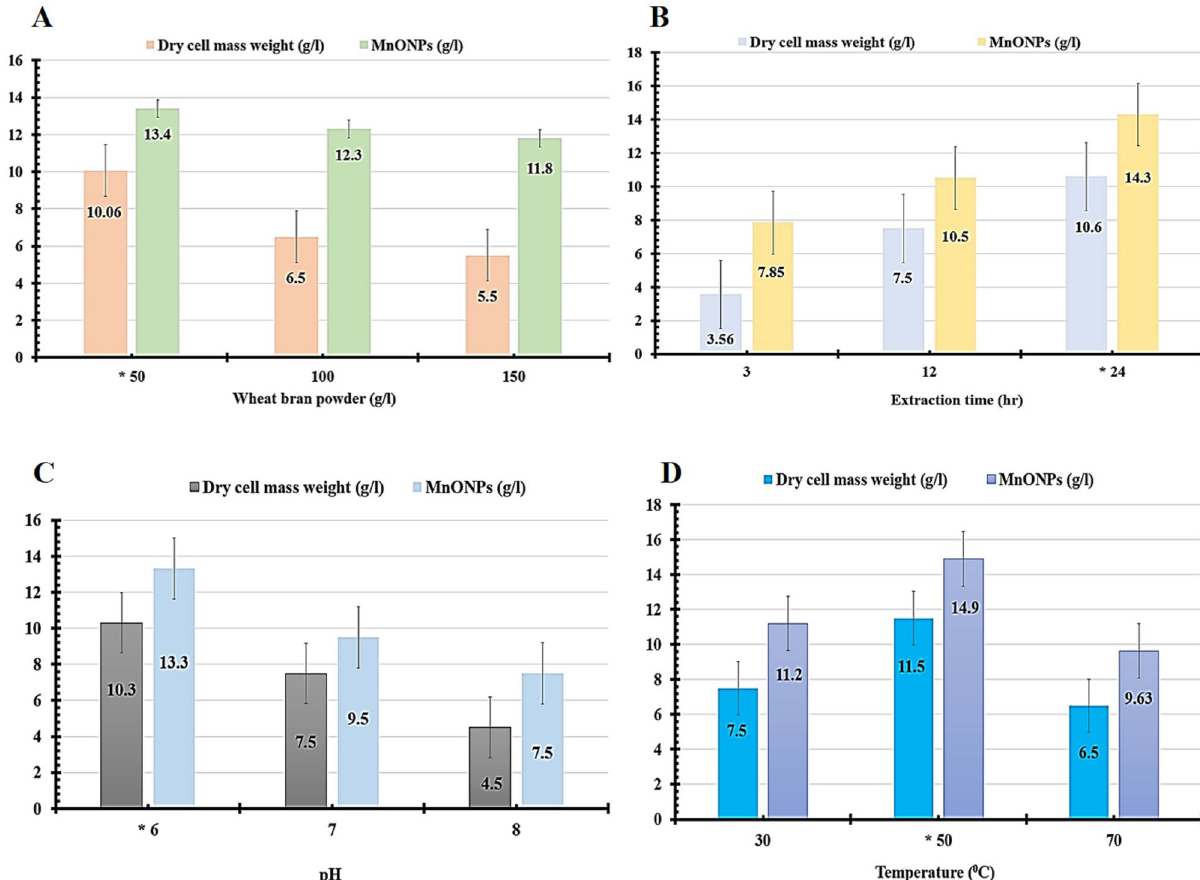
Figure 6. Effective conditions of extraction of soluble nutrients from wheat bran powder that affected the endophytic Trichoderma virens strain EG92 biomass production, and then fabrication of MnO